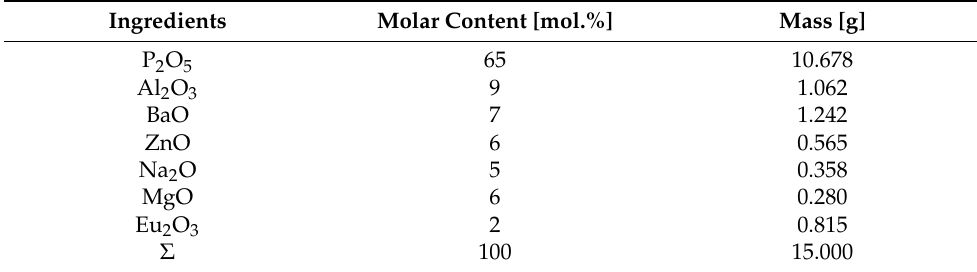
Figure 3. Glass-based sensor head cross sections and the tested sensor’s general view. Table 1. Compositions of phosphate glasses doped with europium ions (2% Eu 3+ ).